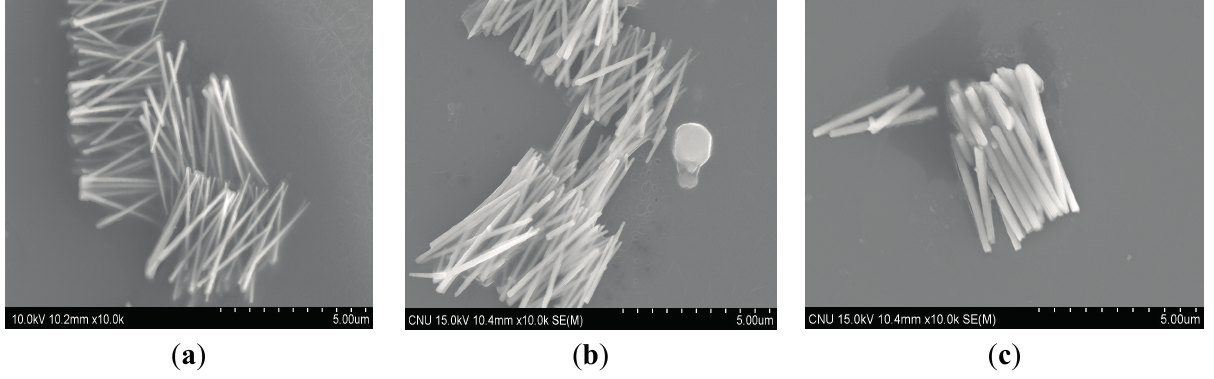
Figure 2. SEM images of CoNiP nanowires with different diameters: ( a ) 100 nm; ( b ) 200 nm; and ( c ) 400